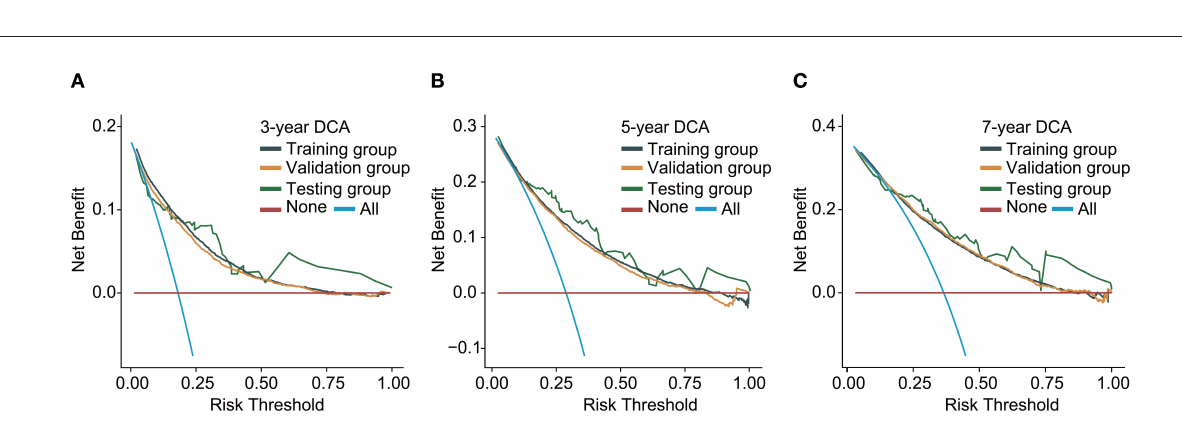
FIGURE8 Decision curve analysis (DCA) curves for assessing clinical usefulness of the condition survival nomogram in training (A) , validation (B) , and testing groups (C)